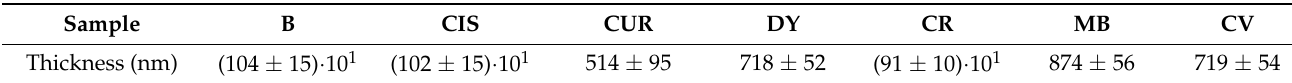
Figure 2. Contact angle values of the samples.